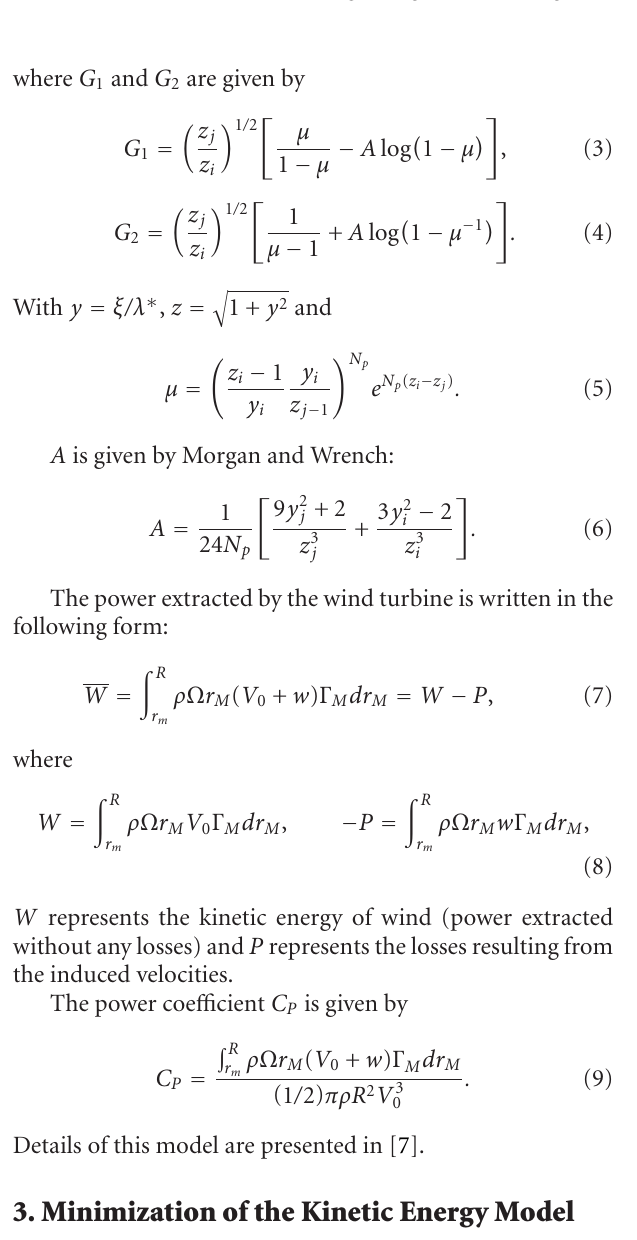
Figure 1: Helicoidal vortex sheet originating from the lifting line.